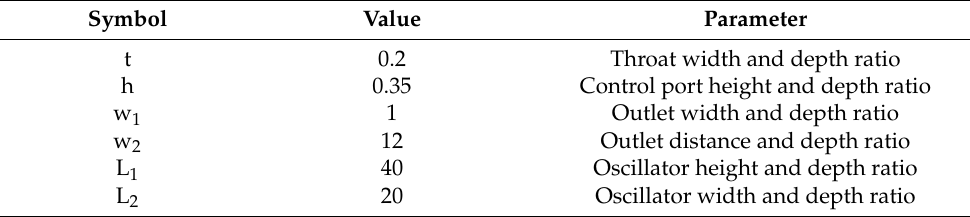
Table 3. The key dimensions of the fluidic